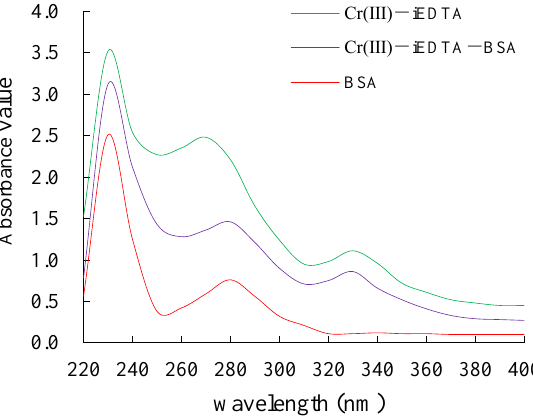
Figure 1. UV spectra of Cr( Ш ) － iEDTA － BSA synthesized using the isothiocyanate method. UV: ultraviolet-visible spectrophotometer. Cr( Ш ) － iEDTA － BSA: Cr( Ш ) is chromium trivalent ion, iEDTA is coupling agent isothiocyanatebenzyl － EDTA, BSA is carrier protein bovine serum albumin, and Cr( Ш ) － iEDTA － BSA is the synthetic immunogen.